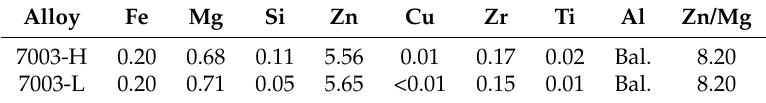
Table 1. Alloy compositions (in wt.%) measured using optical emission